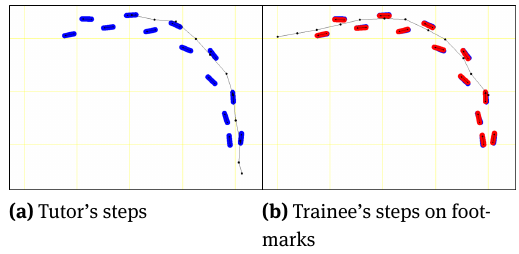
Fig. 23. Result of L-type